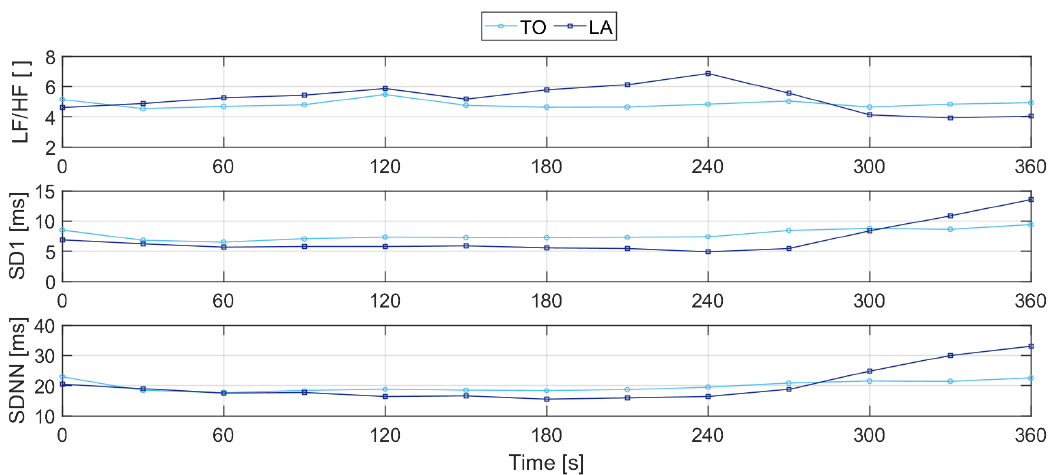
Figure 10. HVR Comparison within flight